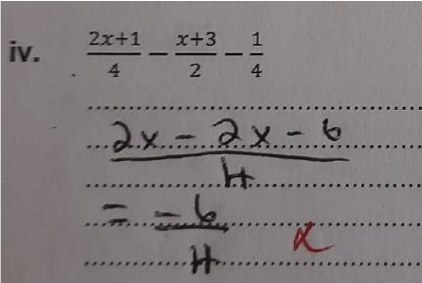
Figure 8: Learner AN, School X.